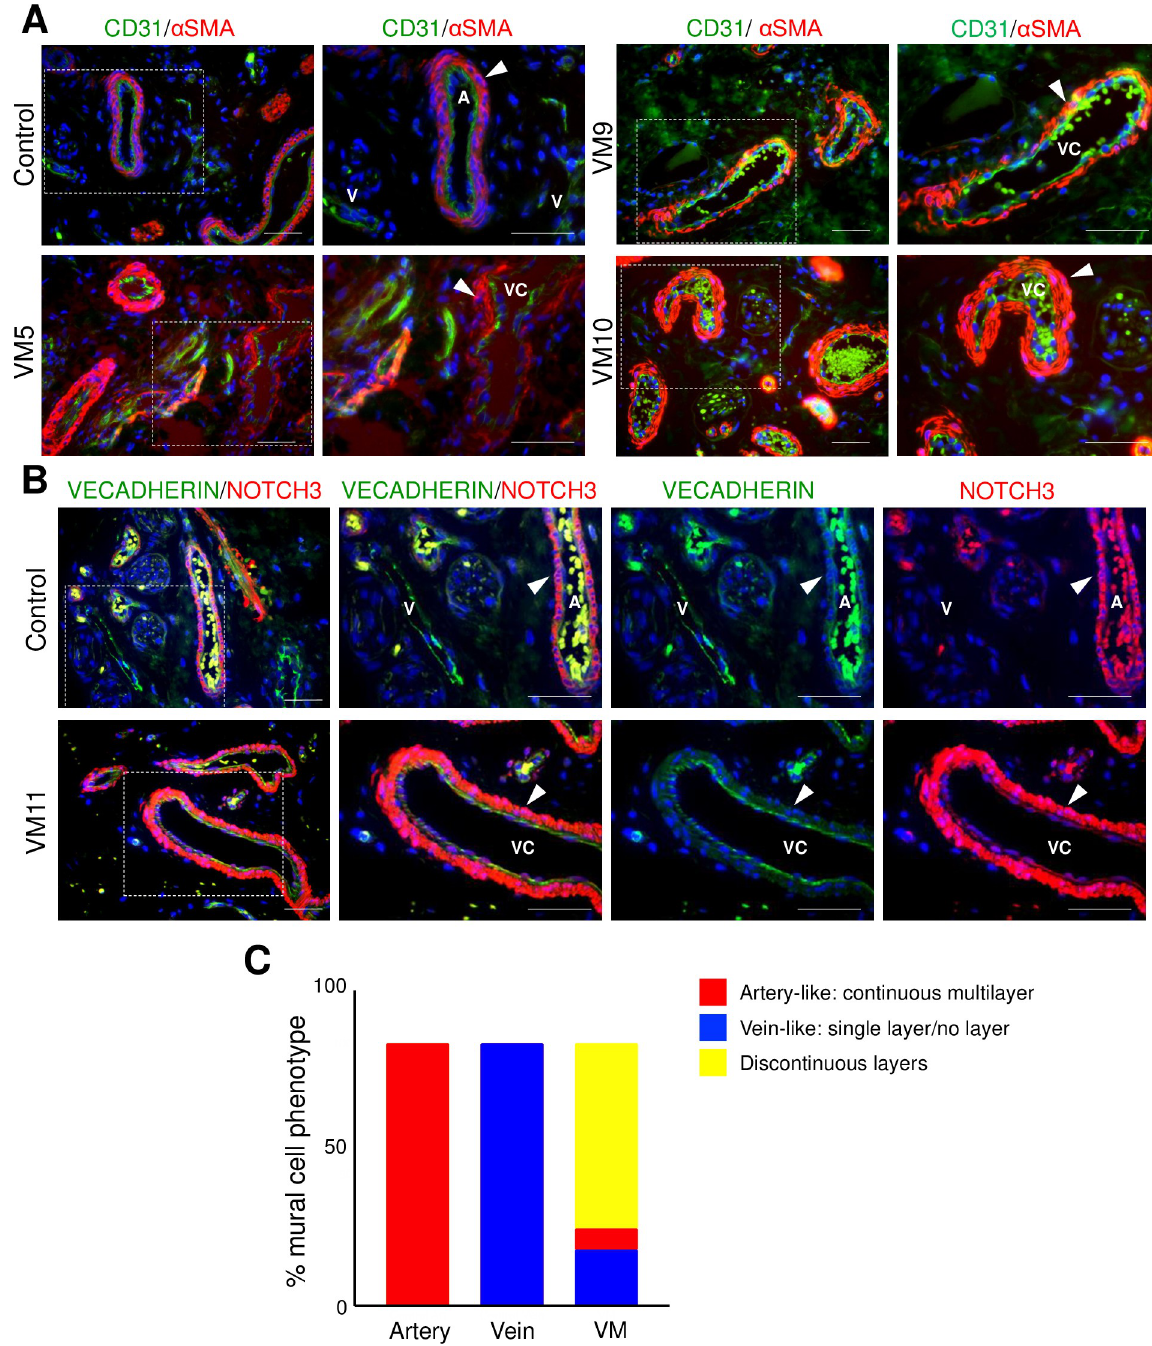
Fig 4. VMs had increased and disorganized α SMA expressing mural cells. (A) Representative images of VM and control neonatal dermis co- stained for CD31 and α SMA. White arrowheads mark CD31-/ α SMA+ mural cells. (B) Representative sections of VMs and control neonatal dermis co-stained for VECADHERIN and NOTCH3. White arrowheads mark VECADHERIN-/NOTCH3+ mural cells. (A, B) Boxed areas are enlarged to the right. A-artery, V-vein, VC-VM channel. Scale bars– 50 μ m. (C) Percentage of mural cell phenotype (arterial-like, continuous multi layer; vein-like, single layer/no layer, and discontinuous layers) in arteries and veins of controls (n = 3), and VMs (n = 11).